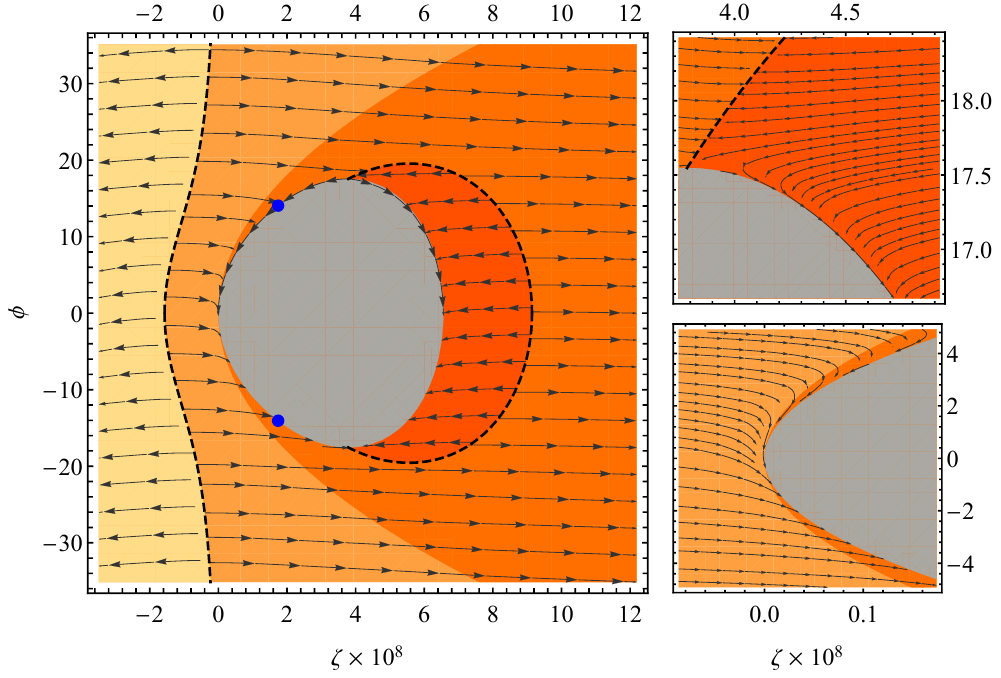
Figure 5. Time evolution of the model (3.1) for the benchmark point in (4.10) in the ( ζ, φ ) plane as given by (4.3), (4.6) (the ˙ φ < 0 , H > 0 branch). Same as figure 4 with differences discussed in the text. The CMB numbers at the blue dot are N e = 50 , A s = 2 . 1 · 10 − 9 , n s = 0 . 952 , r = 0 . 116